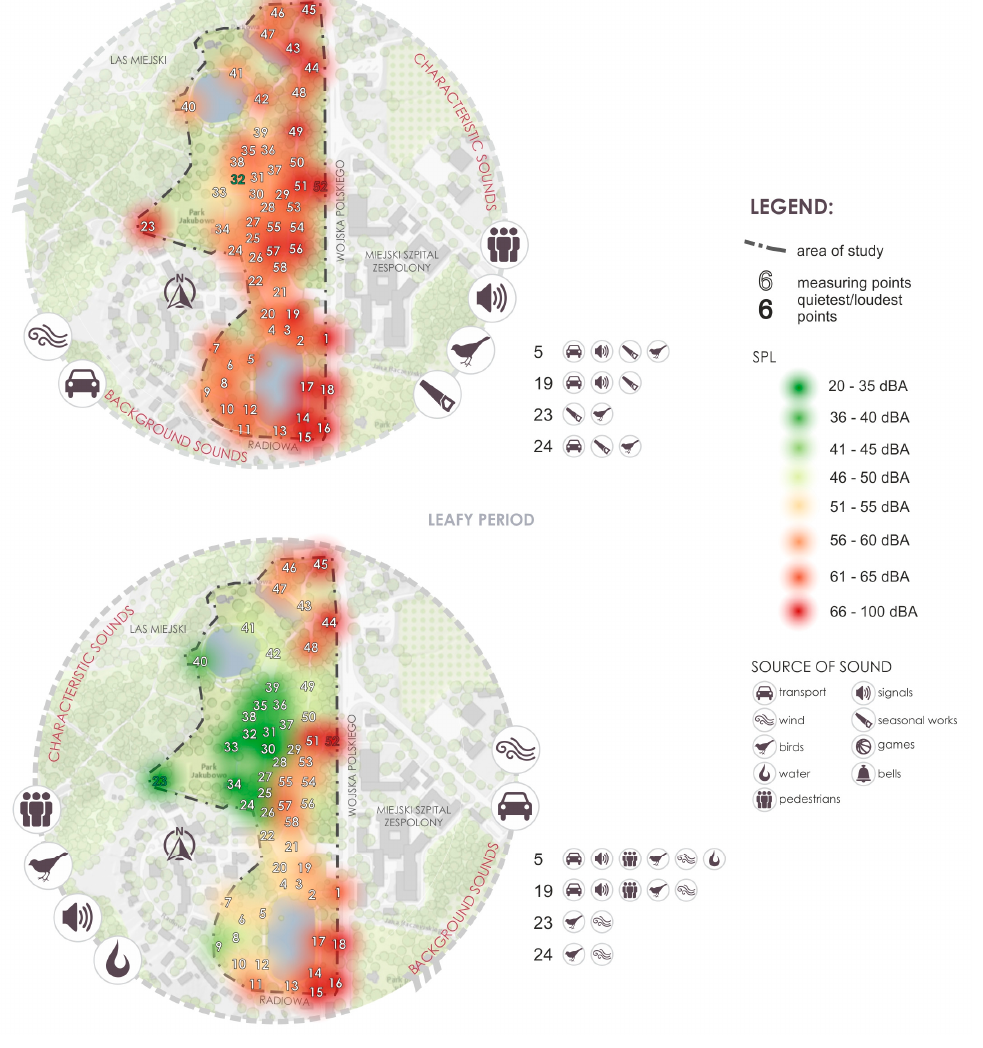
Figure 5. Results of evaluation of the soundscape (SPL measurements and characteristic sounds) presented in a map of the Jakubowo Park in the leafless and leafy period. Traffic is the main source of noise. In the leafless period, point 32 is the quietest, and point 52 is the loudest. In the leafy period, point 23 is the quietest, and point 52 is the loudest. Characteristic sounds in the leafless and leafy period are described as pictograms for points 5, 19, 23, and 24.